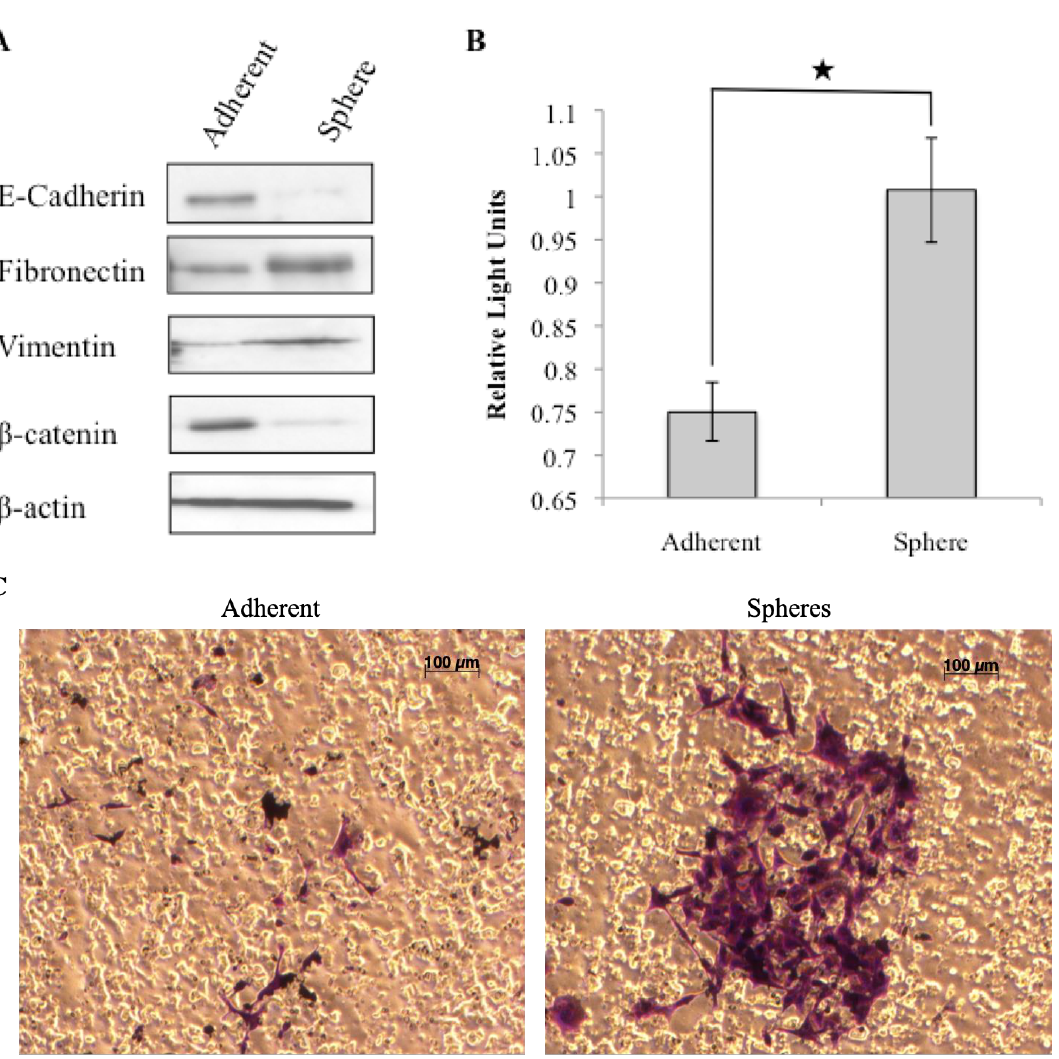
Figure 3. Putative cancer stem cells exhibit mesenchymal characteristics. Tumorspheres derived from the REM134 canine mammary carcinoma cell line express mesenchymal markers (A). Representative images of invading cells, stained purple, embedded within the membrane of a boyden chamber (C) and quantified by colorimetric measurement at 560 nm ( ★ p < 0.008)